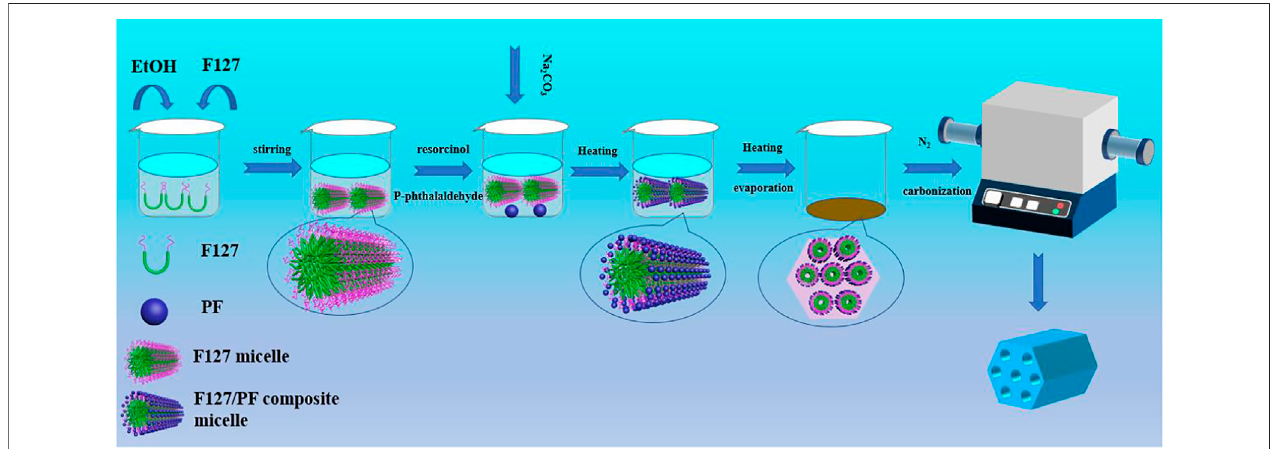
FIGURE 1 | Schematic illustration of the preparation of HPCs through the HISA method in the F127/ethanol micelle system.